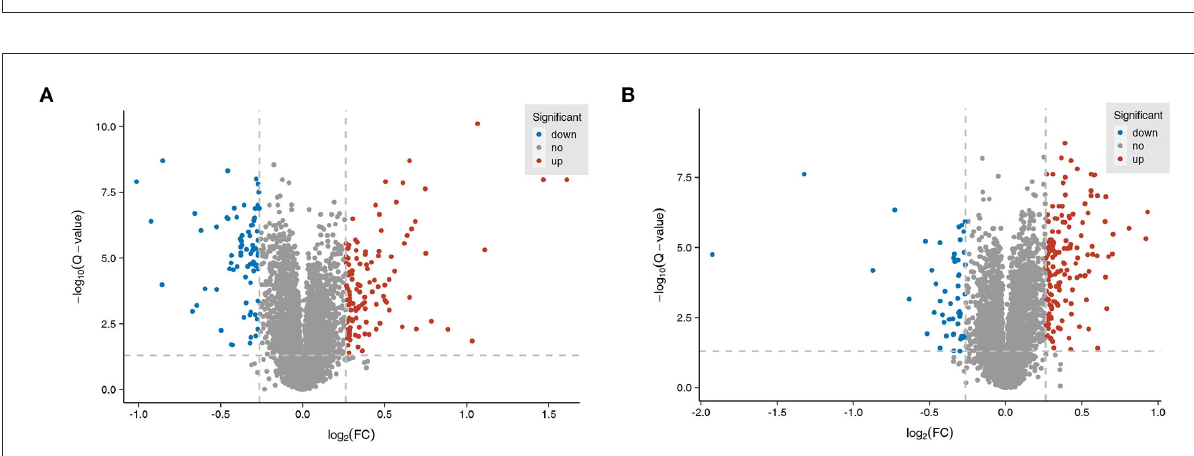
FIGURE4 Identification of dysregulated proteins and biological processes related to MCAO/R-induced brain injury in rats. (A) The volcano plot of differentially expressed proteins in the MCAO/R vs. sham group. (B) The volcano plot of differentially expressed proteins in the EA vs. MCAO/R group. Each group contained nine hippocampal tissue samples isolated from nine rats, and three samples per group were mixed into a proteomics